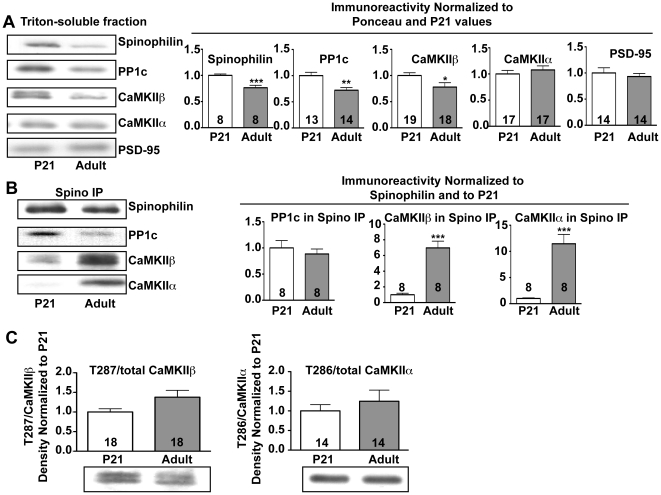
The interaction of CaMKII with spinophilin increases with age.
A. TSFs isolated from PND21 or adult striatum were immunoblotted for spinophilin, PP1 catalytic subunit (PP1c), CaMKIIβ, CaMKIIα, or PSD-95. B. Spinophilin was immunoprecipitated from TSFs isolated from PND21 (P21) or adult animals. Precipitates were immunoblotted for spinophilin, PP1c, CaMKIIβ, or CaMKIIα. C. Striatal TSFs from PND21 or adult mice were immunoblotted for phospho-Thr286/7 and total CaMKII. Phospho-Thr286/7 immunoreactivity was normalized to total CaMKIIβ or CaMKIIα levels, respectively. All values were normalized to the mean at PND21, and then expressed as the mean±S.E.M from analyses of the indicated number of animals. * P<0.05, **P<0.01, ***P<0.001.